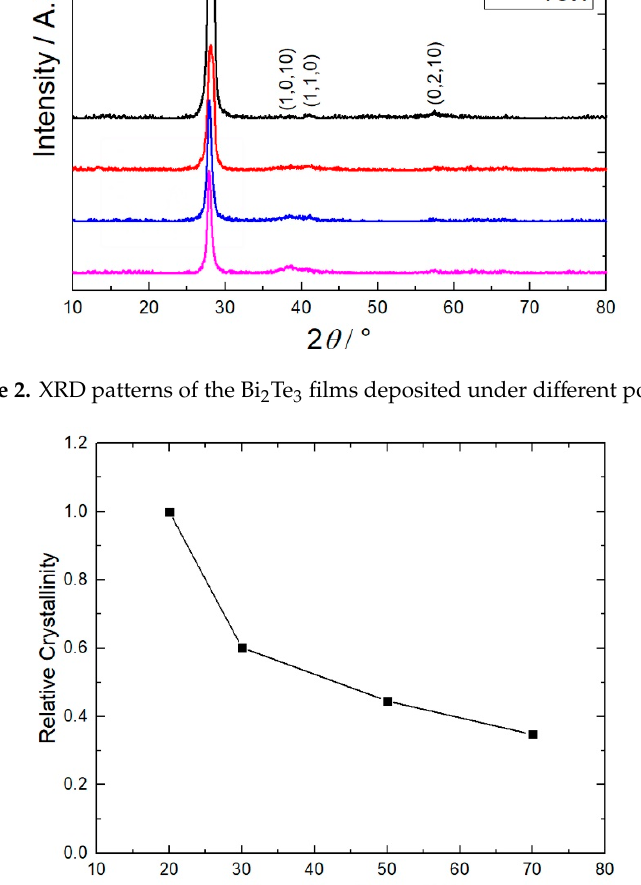
Figure 3. Relative crystallinity of the Bi 2 Te 3 films deposited under different powers